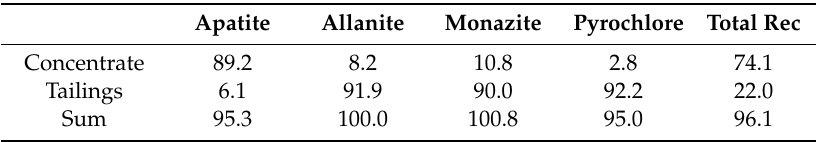
REE-bearing Table 8. Recoveries of total rare earth oxide (TREO) in the concentrate and tailings from different REE-bearing minerals.